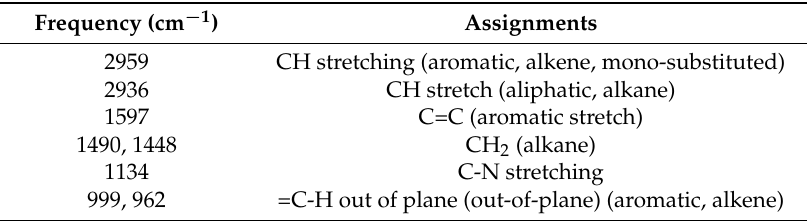
Table 5. Principal peaks with assignments of cinnarizine pure